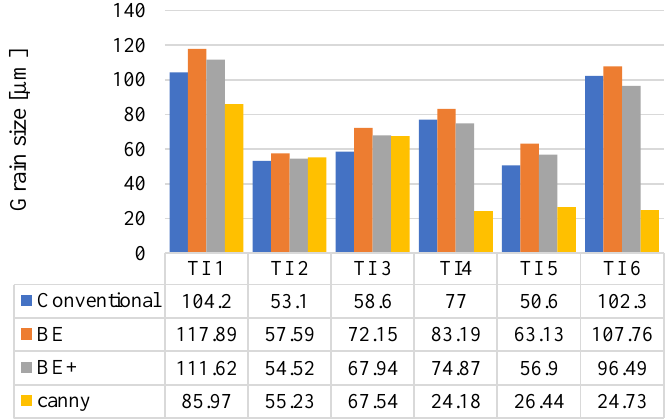
Figure 9. Results of average grain size predictions of tested images TI1 to TI6, based on the conventional method, BE, BE + and Canny edge detection filter.